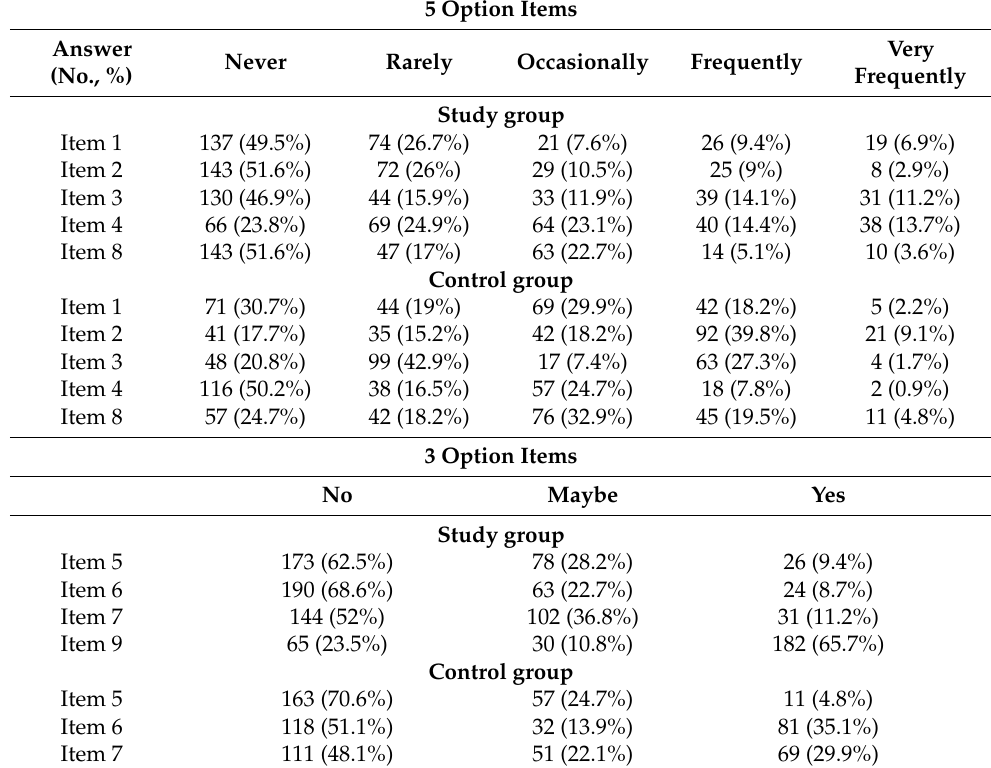
Table 3. Distribution of the patients according to the answers provided. 5 Option